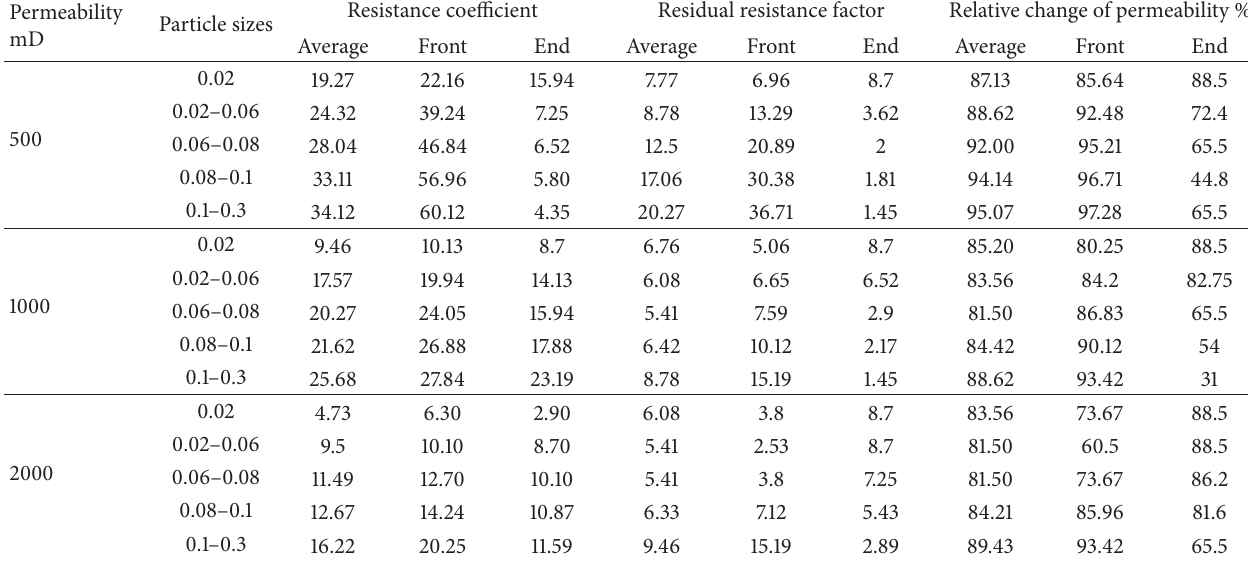
Table 2: Experimental